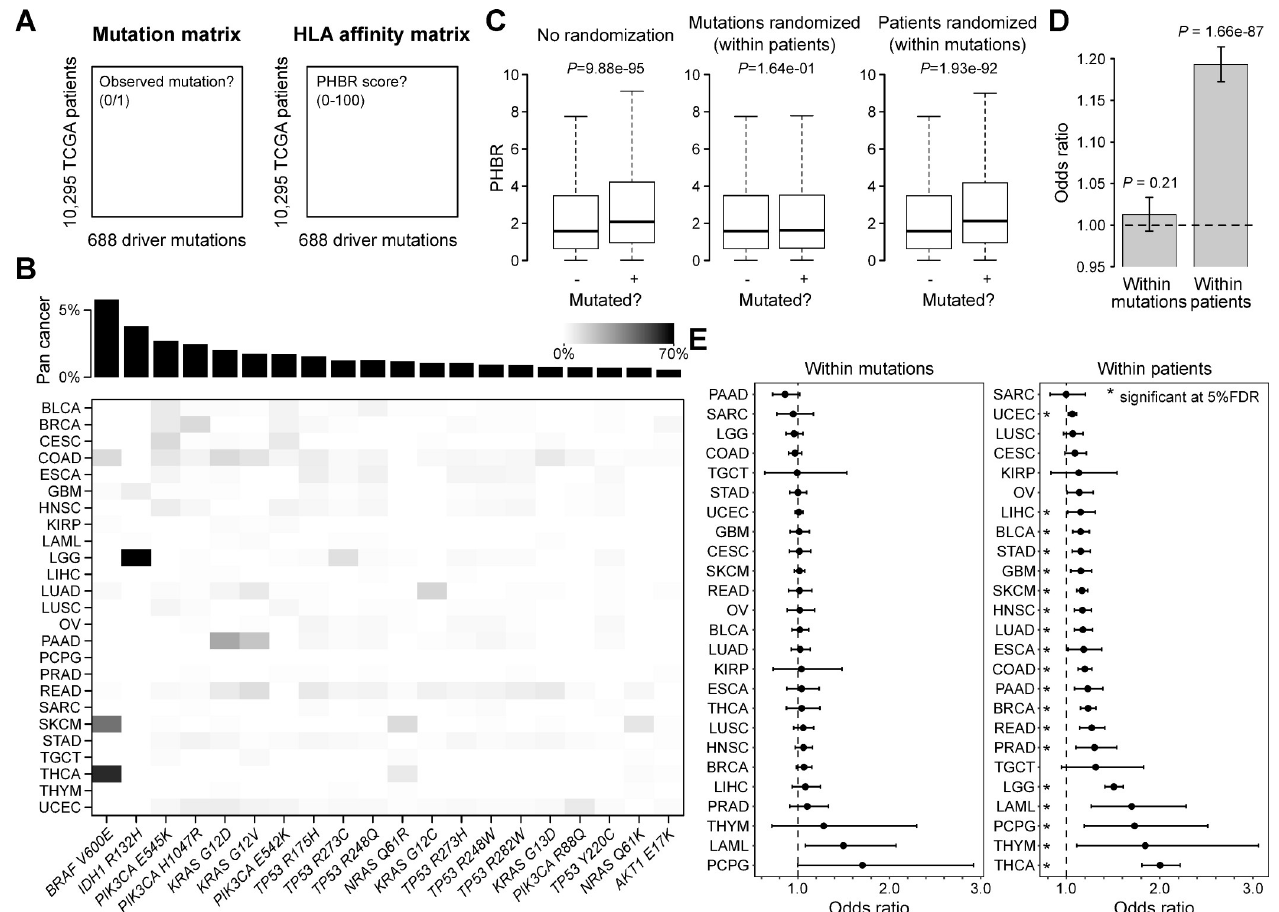
Fig 1. TCGA driver mutation and HLA affinity analysis. (A) Illustration of the 2 matrices underlying the study’s analytical approach. Driver hot spot missense mutations were identified in TCGA data (see Methods ) and a patient x mutation matrix was generated with each cell containing a binary value (mutation observed or unobserved). A corresponding HLA affinity matrix was then calculated with values representing PHBR values. (B) Mutation frequencies for the 20 most frequent driver mutations. Grey scale shown in top right. Pan cancer mutation frequencies indicated by bar plot on top. (C) Box plots compare PHBR values between observed (+) and unobserved (-) mutations with or without randomization of patients/mutations as indicated. Box plots indicate median values and lower/upper quartiles with whiskers extending to 1.5 times the interquartile range. P values calculated using Wilcoxon rank-sum test. (D-E) Pan cancer (D) and per cancer (E) logistic regression analysis between log PHBR (observed variable) and mutation status (0/1, response variable). Analysis was performed both using the within-patient (rows of the matrices) and within-mutation (columns) regression model as indicated (see Methods for details). Bar plot (D) and dots (E) show odds ratios with 95% confidence intervals. Asterisks indicate significance at 5% FDR.